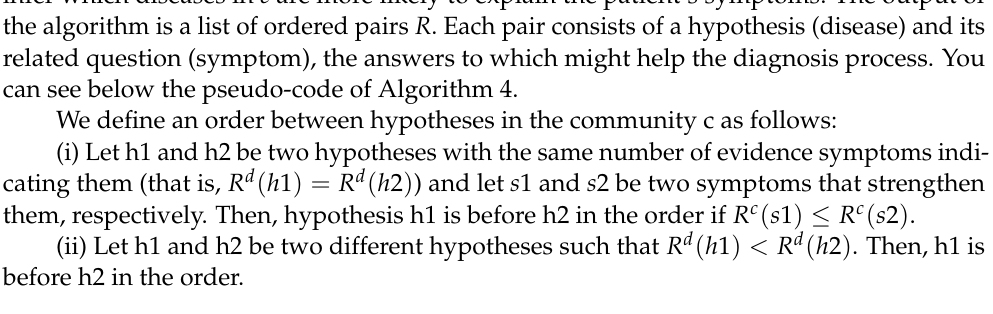
Algorithm 4: Find Disease